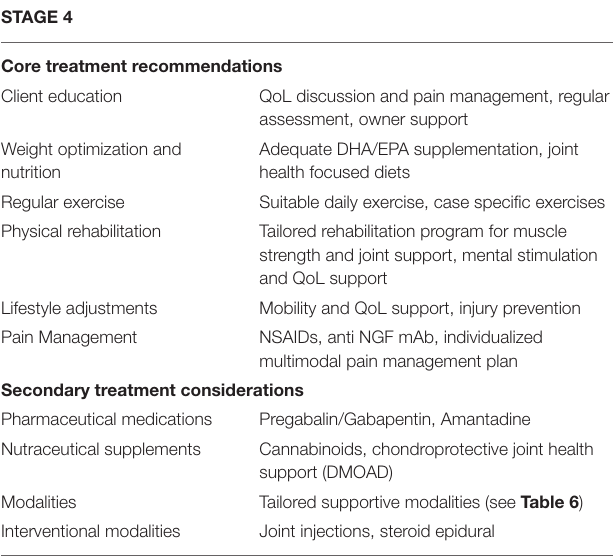
TABLE 5 | Summarized core and secondary treatment recommendations for COAST Stage